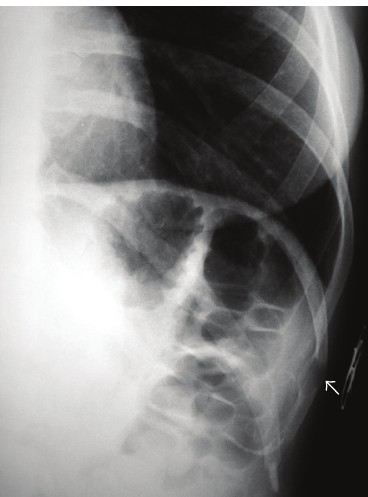
Figure 1: Conventional radiograph of the left lower ribs shows a well-circumscribed, ovoid lytic lesion (arrow) near the anterior aspect of the left tenth rib, causing thinning of the cortex and expansion of the bone.